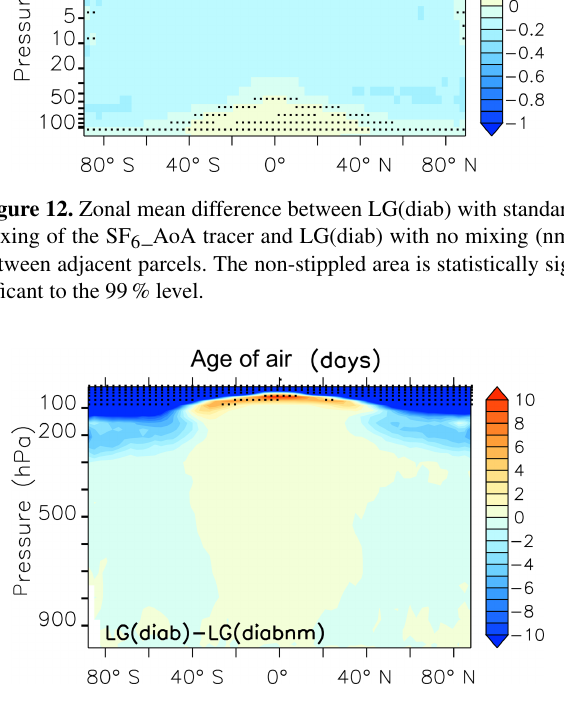
Figure 13. Zonal mean difference between LG(diab) and LG(diab- nm) with no inter-parcel mixing. The stippled area is statistically significant to the 99% level.